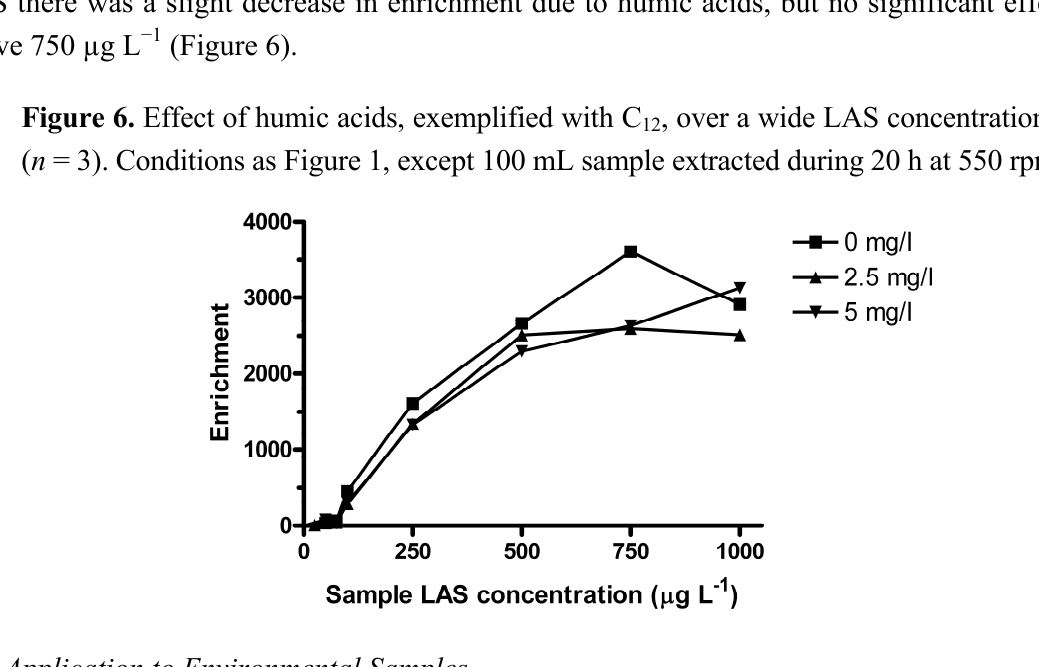
, over a wide LAS concentration range 12